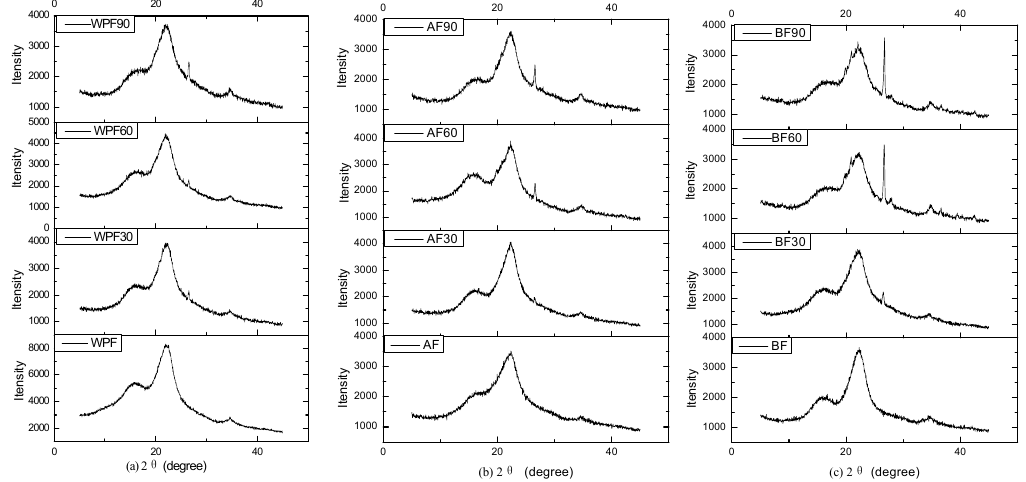
Figure 3. X-ray diffractograms for ( a ) windmill palm fiber ( b ) alkali-treated fiber and ( c ) bleached fiber before and after soil burial.